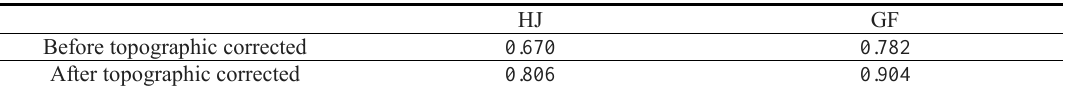
Fig.3.3. the reflectance of shadow slope and Sun slope with no topographic correction and topographic with this model, GF (a), HJ (b) Table.3.1 The covariance between multi-source image and Landsat8 OLI image.